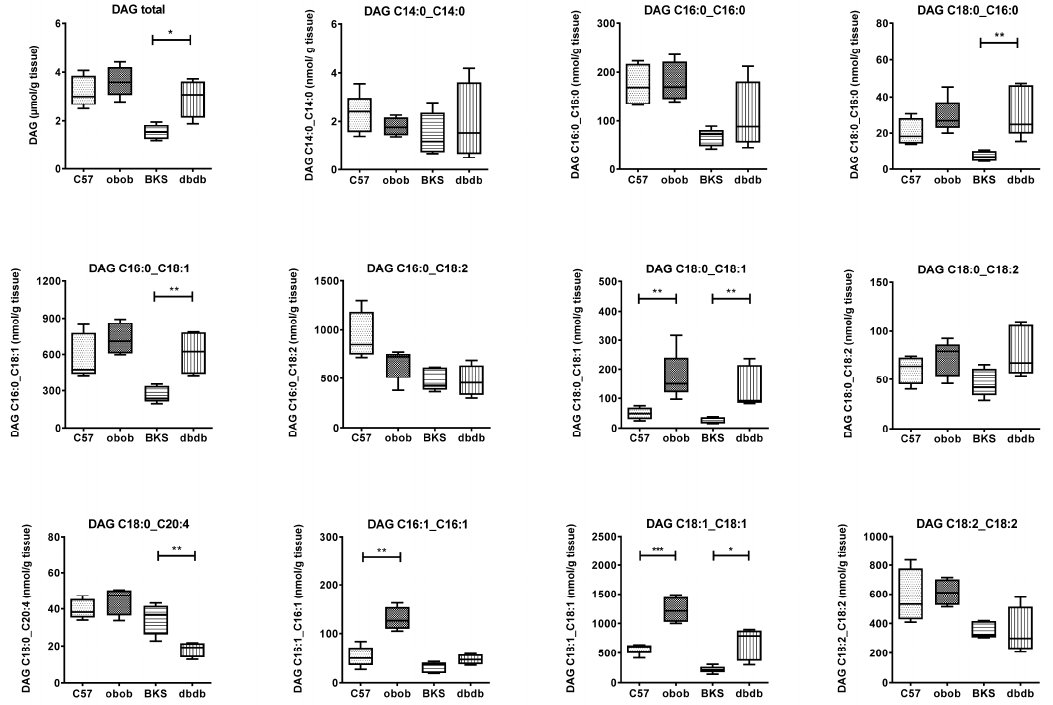
Figure 4. Diacylglycerol pattern in adipose tissue of C57, BKS, obob and dbdb mice. Data are given in ( μ mol or nmol/g tissue) and expressed as mean ± SD ( n = 5 of each phenotype). * p < 0.05, ** p < 0.01, *** p < 0.001 by Student’s t test.